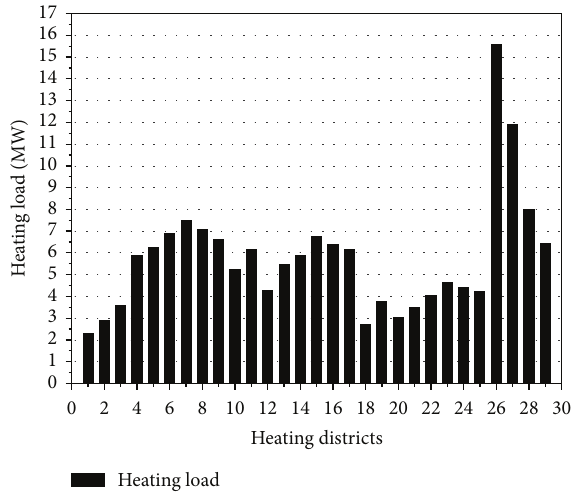
Figure 4: Heating load of 29 heating districts.